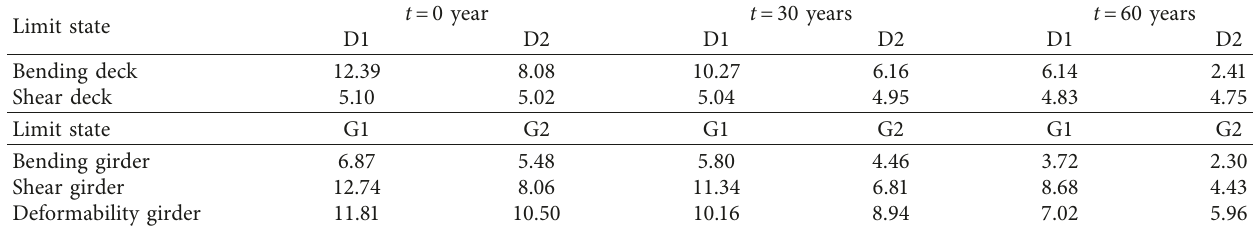
Table 5: Minimum β indexes for the two design alternatives and for different lifetimes.